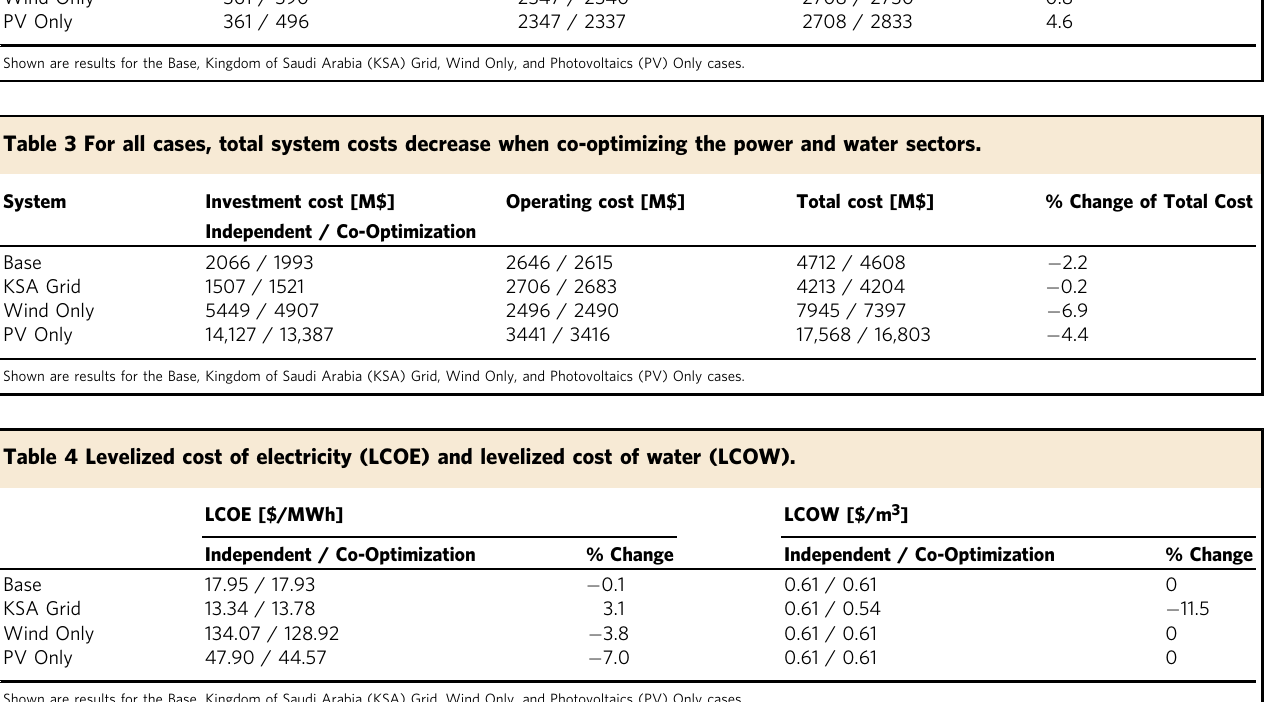
Shown are results for the Base, Kingdom of Saudi Arabia (KSA) Grid, Wind Only, and Photovoltaics (PV) Only